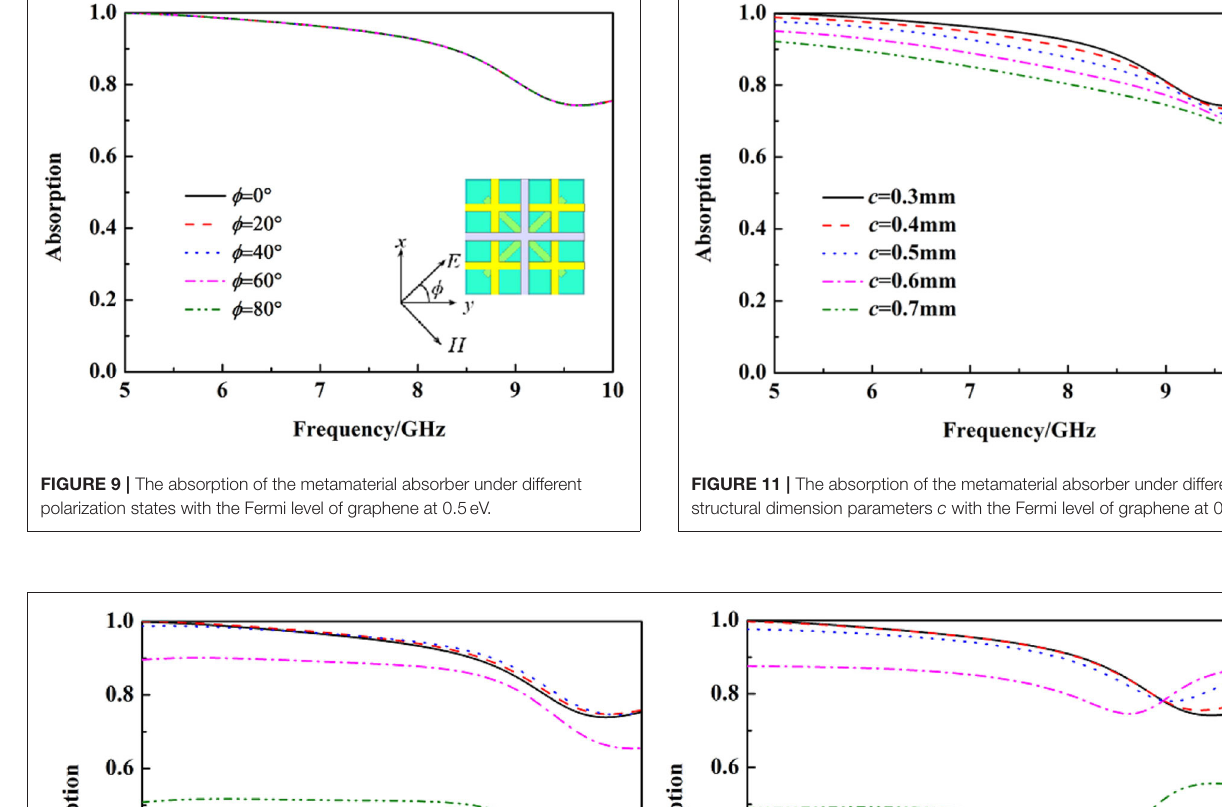
Frontiers in Physics |